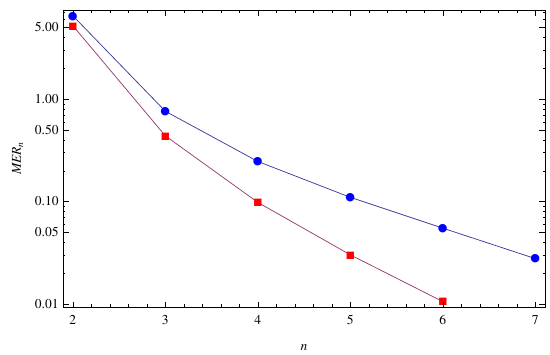
Figure 14: Comparison of the logarithmic plots of MER n : circle dot for the 3-stage ADM solution with equal-length subintervals and square dot for the 3-stage ADM solution with unequal-length subin-